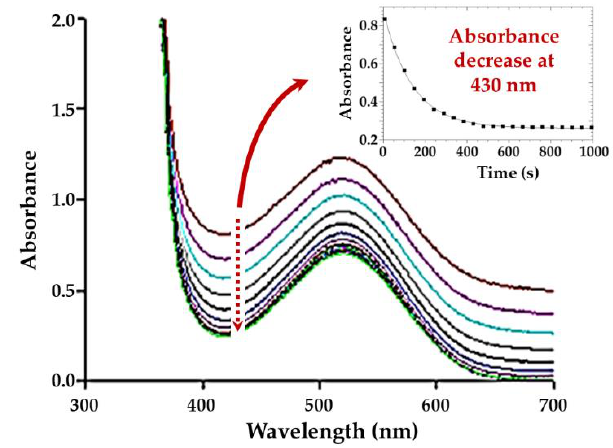
Figure 2. UV/Vis spectral change for the substitution of triphenylphosphine oxide in cis - [NbO(ca) 2 (H 2 O)OPPh 3 ] − ( 5a ) ([0.001 M]) by DMAP ([0.35 M]) at 31.2 ° C, 430 nm in acetonitrile; ∆ t = 50 s, total time of 1000 s. The insert indicates the absorbance change versus time at 430 nm, and the solid line shows the least-squares fit as described previously [23,24] for the first-order reaction ( k obs = (7.6 ± 0.2) × 10 −3 s −1 ).